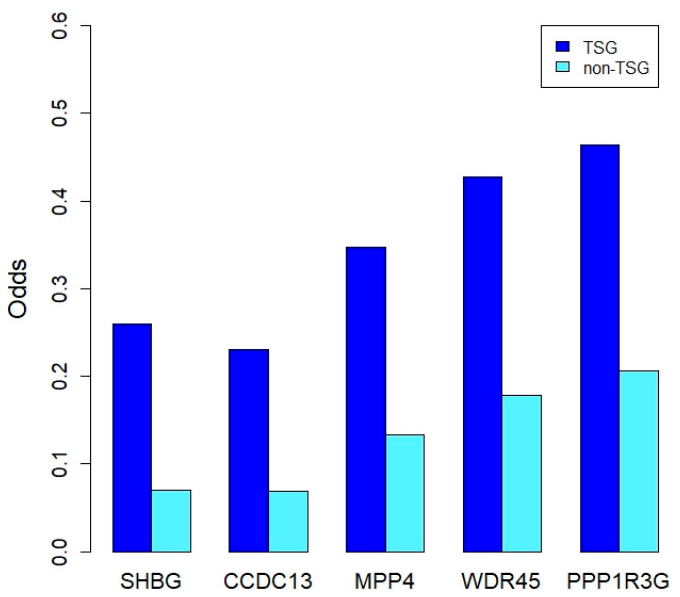
Figure 5. Genes that have differential coexpressions with TSGs more frequently. The y axis indicates odds that are a ratio of the number of differentially co-expressed genes with tumor suppressor genes to the number of no co-expressed genes for a single gene. Therefore, a high odds ratio indicates that a gene is more frequently significant with TSGs, implying that the gene has regulatory relationships with TSGs. 2.3. Identification of Copy Number Alterations Having an Impact on Methylations and Gene Expressions Copy number alterations (CNAs) indicate a change in the genome structure related to TSGs [29]. Therefore, if CNAs have functional impacts on gene expressions or other functional changes, they have a high possibility of being a TSG. For the identification of such functional impacts of CNAs, multi-omics data analyses were performed with CNAs, methylation, and gene expression data from the TCGA breast cancer dataset downloaded from the cBioPortal website [36]. As described in the Materials and Methods, a linear model was applied to detect CNAs with an impact on methylation or gene expression. In the analysis, methylations or gene expressions were regressed on CNAs of the corresponding genes. When methylations and gene expressions were fitted to CNAs, only the cis effect of CNAs of the corresponding gene was tested. In the CNA-methylation analysis, cBioPortal provided mappings between the genomic locus of methylation and genes. The gene was assigned to one of the nearby methylation loci when a correlation of the gene and methylation loci was strongest. CNAs and methylations of 15,027 genes were used in the CNA-methylation anal- yses. The TCGA breast cancer multi-omics dataset included 551 concurrent samples in methylation and CNA data. After multiple testing correction, 3528 CNA-methylation pairs were significant (Bonferroni’s adjusted p -value < 3.33 × 10 − 6 ). There were 137 TSGs in the significant result set, and 330 TSGs in the nonsignificant result set. Analysis of the Fisher’s exact test results revealed that the TSGs were underrepresented in the significant CNA-methylation pairs (odds ratio = 0.73, p -value = 3.23 × 10 − 3 ). When the p -values of the linear model between methylations and CNAs were compared between the TSGs ( n = 467) and non-TSGs in the downregulated genes, the result was highly significant (Figure 6, Wilcox rank-sum test p -value = 2.75 × 10 –4